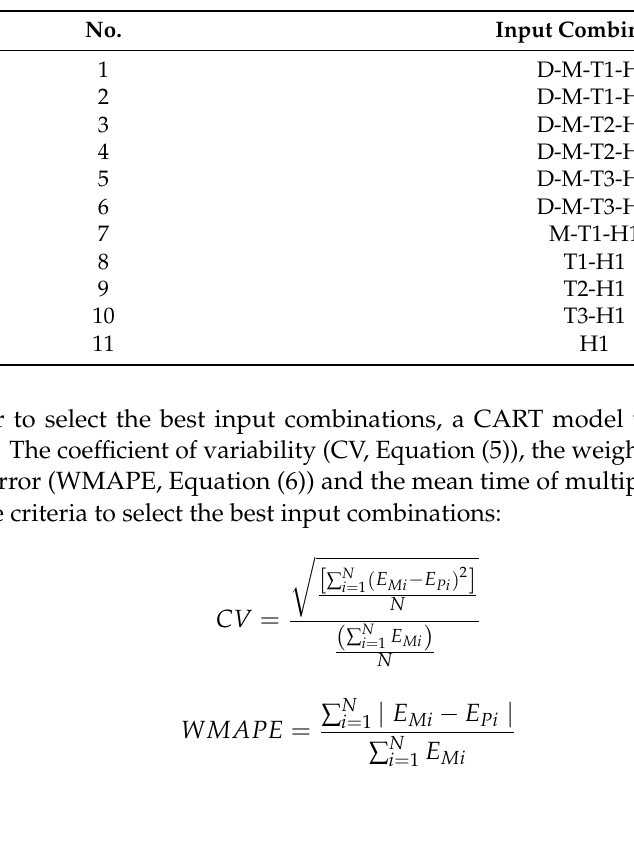
Table 3. For example, No. 1 means to select D, M, T1 and H1 as the model inputs. Table 3. Summary of different schedule input